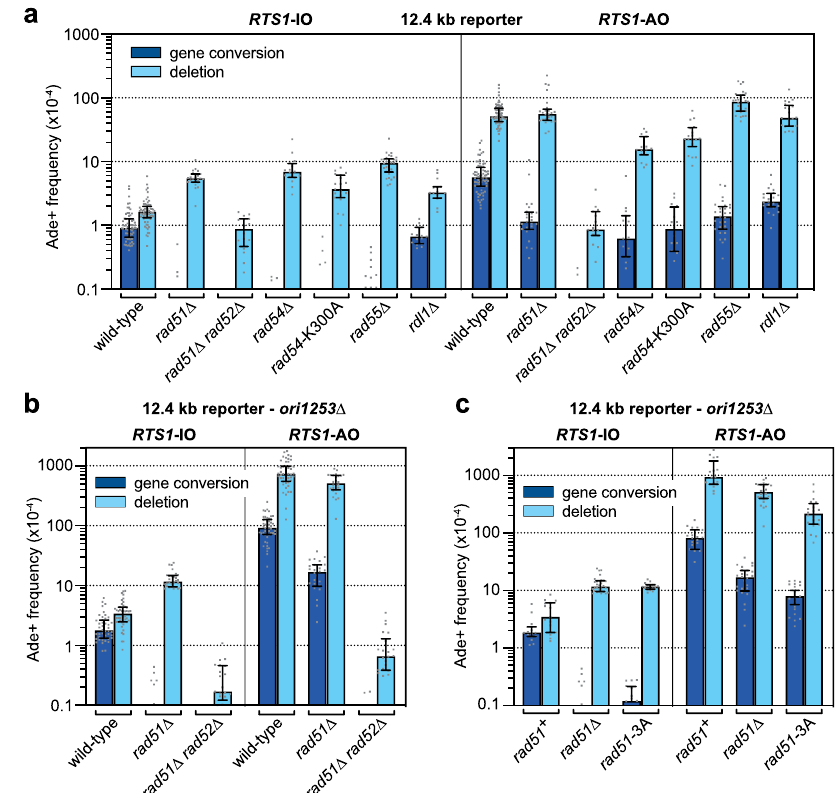
Fig. 3 | RDR-associated template switching is only partially dependent on Rad51 and Rad51 is only a partial barrier to Rad51-independent template switching. a Frequency of spontaneous ( RTS1 -IO) and RTS1 -AO-induced Ade + recombinants in wild-type and mutant strains carrying the 12.4kb reporter. b Frequencyofspontaneous( RTS1 -IO)and RTS1 -AO-inducedAde + recombinantsin wild-typeandmutantstrainswith ori-1253 Δ andthe12.4kbreporter. c Frequencyof spontaneous ( RTS1 -IO) and RTS1 -AO-induced Ade + recombinants in rad51 + , rad51 Δ